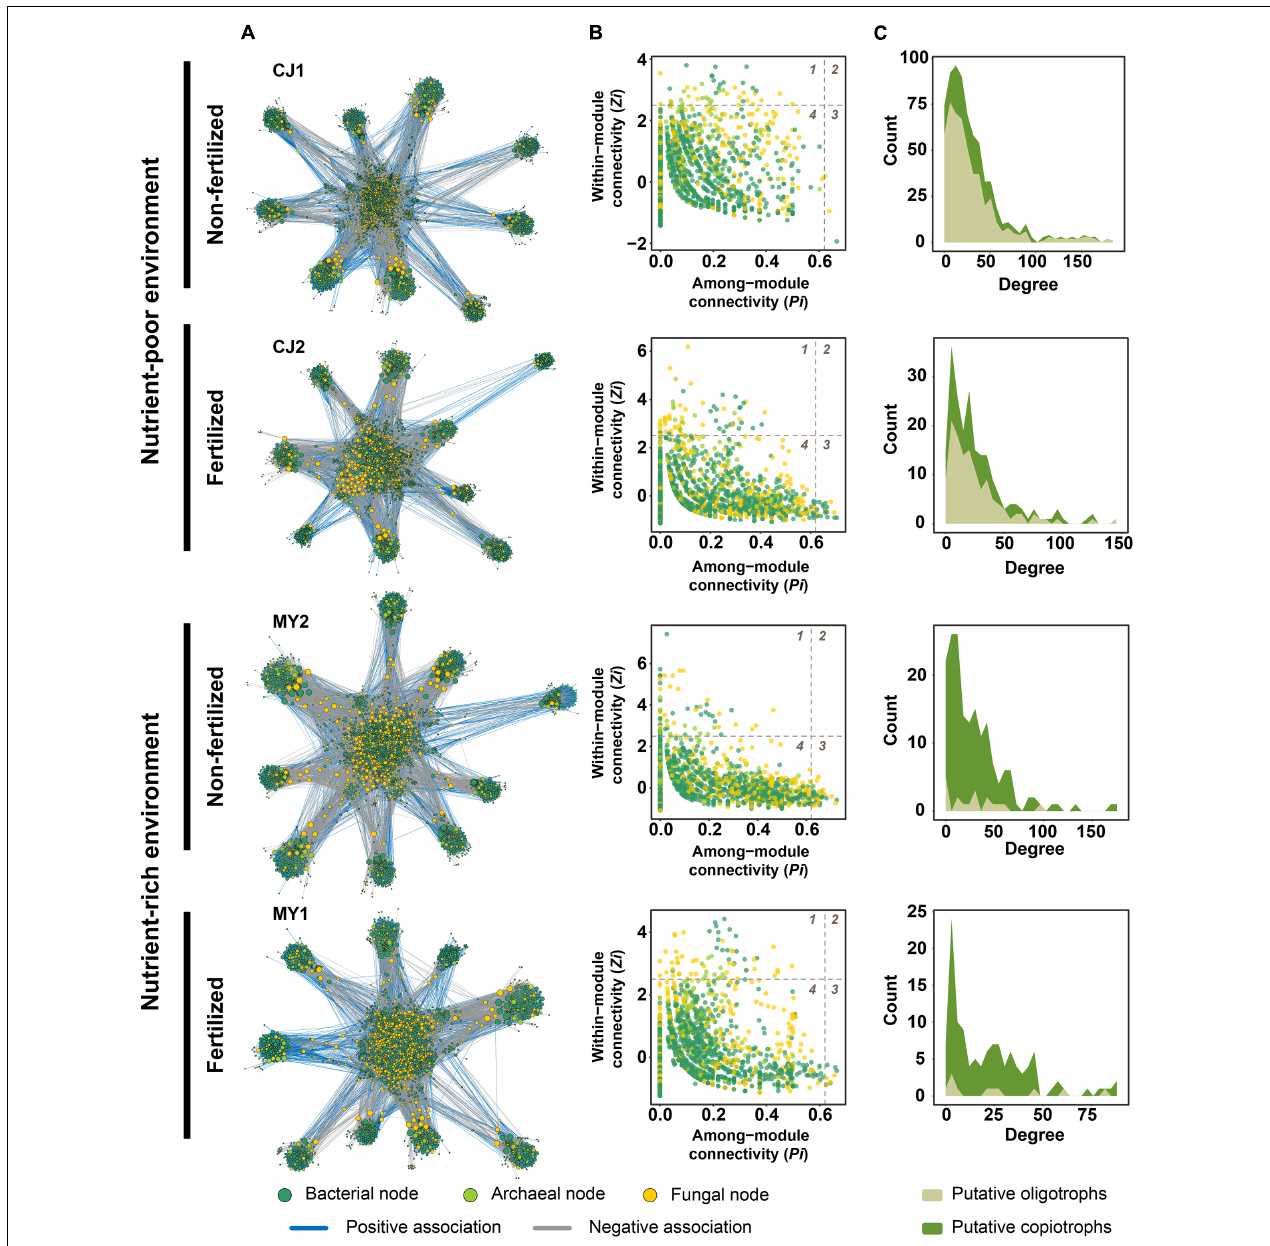
FIGURE 5 | Microbial networks and hub nodes of soil microbial communities under non-fertilized and fertilized conditions in nutrient-poor and nutrient-rich environments. (A) Co-occurrence network of microbial OTUs detected in fields managed with different fertilization regimes in nutrient-poor and nutrient-rich environments. Each node corresponds to an OTU, and edges between nodes correspond to either positive (blue) or negative (gray) correlations inferred from OTU abundance profiles using the SparCC method ( P < 0.05, correlation values < –0.6 or > 0.6). OTUs belonging to different microbial kingdoms are indicated with colors (Bacteria, green; Archaea, light green; Fungi, yellow), and the node size reflects their degree centrality. (B) Hub OTUs of microbial networks under each condition. Dashed lines indicate thresholds estimated using within-module connectivity ( Zi ) and among-module connectivity ( Pi ) values in which the roles of nodes are discriminated. The numbers of the quadrants indicate the roles of the nodes in the networks. 1, module hub ( Zi > 2.5 and Pi < 0.62); 2, network hub ( Zi > 2.5 and Pi > 0.62); 3, connector ( Zi < 2.5 and Pi > 0.62); 4, peripheral ( Zi < 2.5 and Pi < 0.62). (C) Distribution of degrees of putative oligotrophs and copiotrophs in microbial networks. The degree indicates the number of associations (edges) shared by each node in a network.